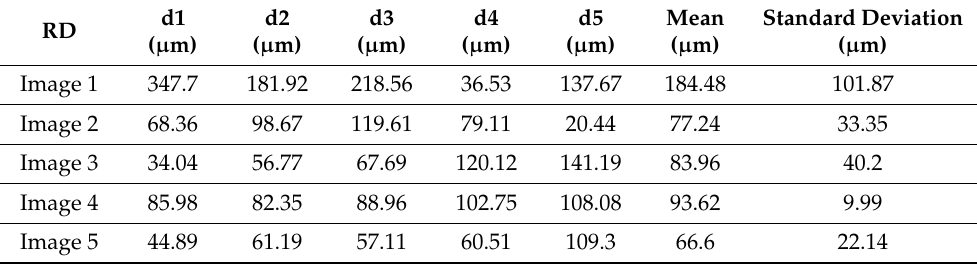
Figure 15. Images captured from microscope interface and measurements of the gaps between assembles framework components fabricated through 3 methods. Table 5. Measurements of the gap ( µ m) present at the joint between the components of the assembly of prosthetic frameworks made by the refractory duplicate method-RD.